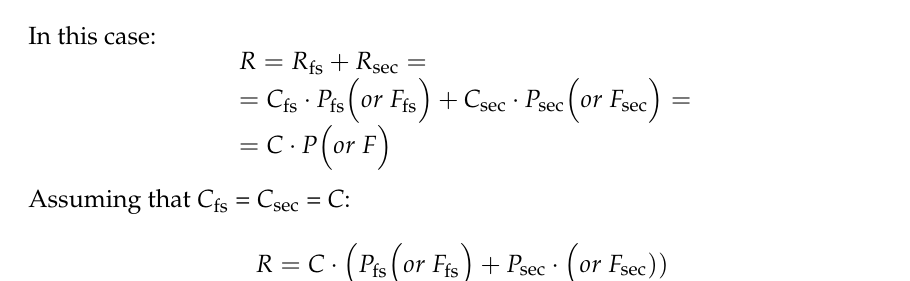
Figure 7. Risk Cube SIL-EAL (col.).